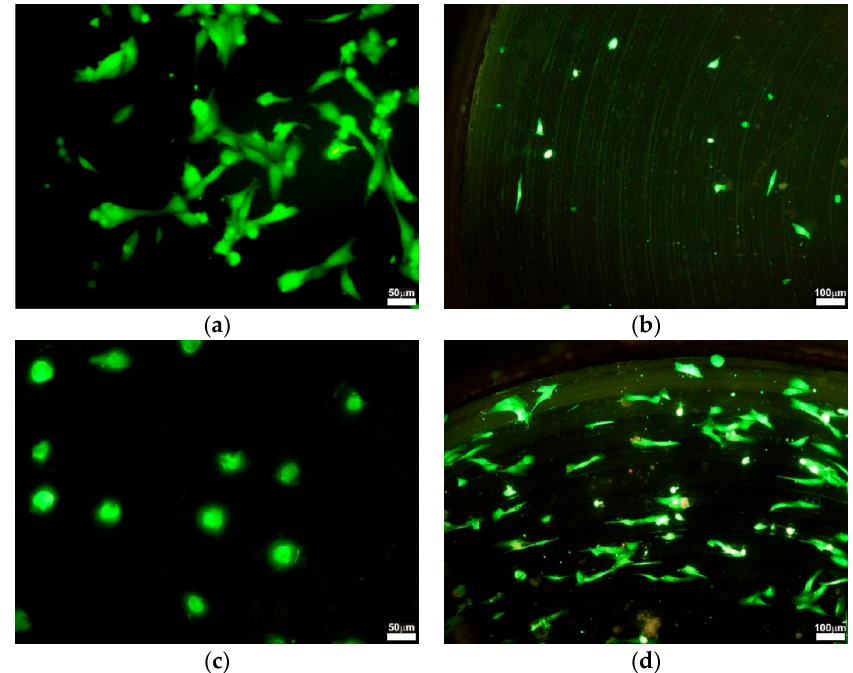
Figure 5. Osteoblasts on different types of studied materials: ( a ) Control cells on the plastic tissue plate; ( b ) Cells on nTi2; ( c ) Cells on laser-treated nTi4L; ( d ) Cells on nTi4.